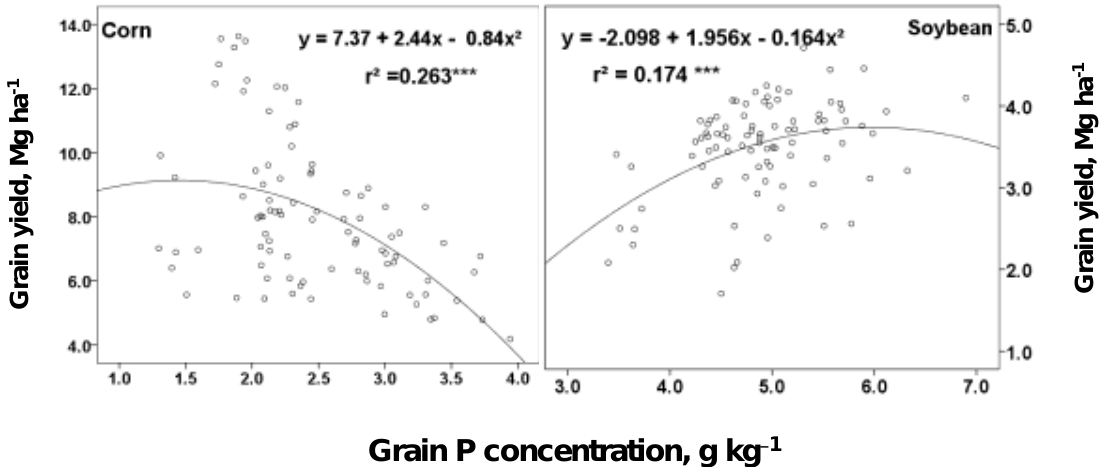
Figure 5. Relationship between grain P concentration (GPC) and grain yield for corn and soybean across five corn-soybean rotations (2004–2013) in a clay loam soil, Woodslee, ON, Canada. ***, significant at p ≤ 0.001.